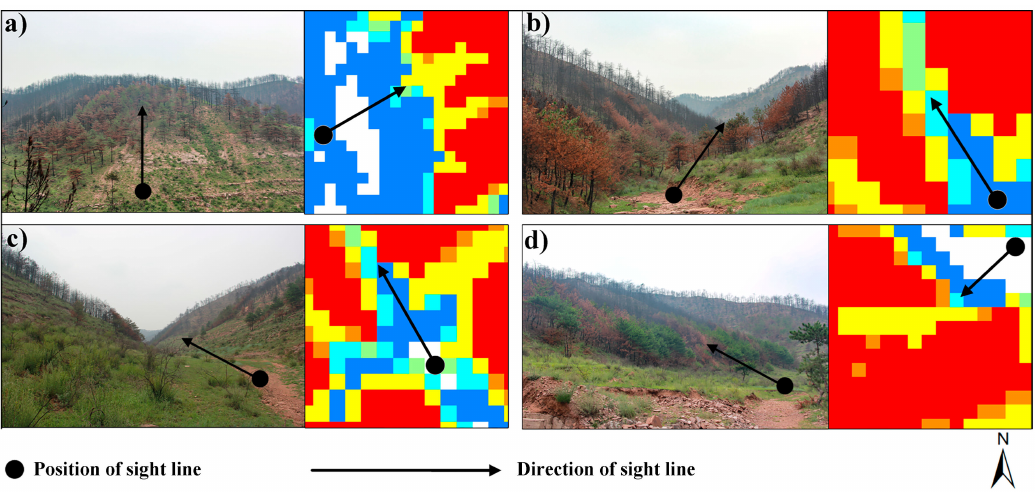
Figure 9. Examples of panoramic landscape photos (left of a – d ) and burn severity map (right of a – d ) to demonstrate the validity of the method proposed in this study. The black point represents the position of sight, the arrows represent the direction of the sight. The qualitative validation indicated that the burn severity map and the panoramic landscape photos showed good spatial distribution